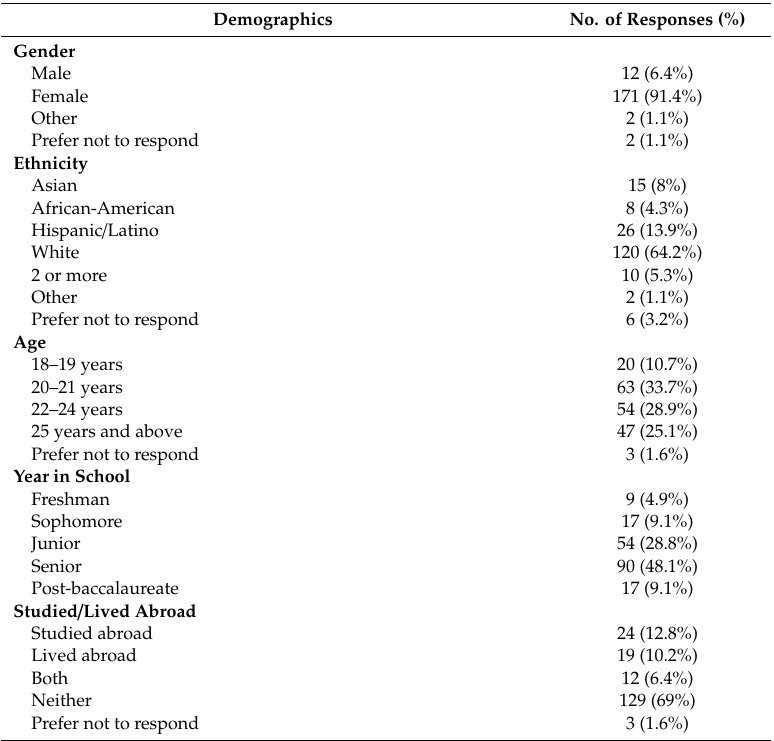
Table 2. Demographics ( n =